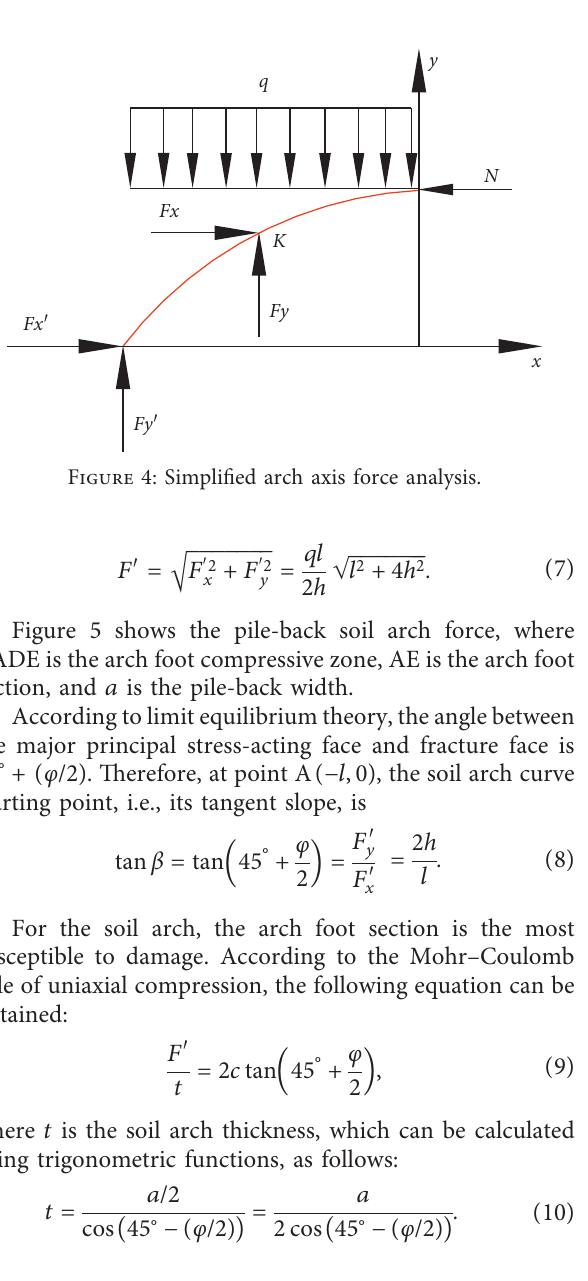
Figure 3: Soil arch plane graph for calculation.